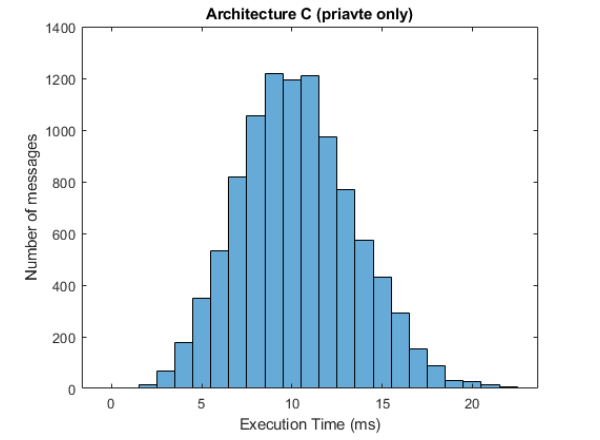
Figure 13. Histogram for architecture C (100% private messages). Table 4. Comparison of simulation results.